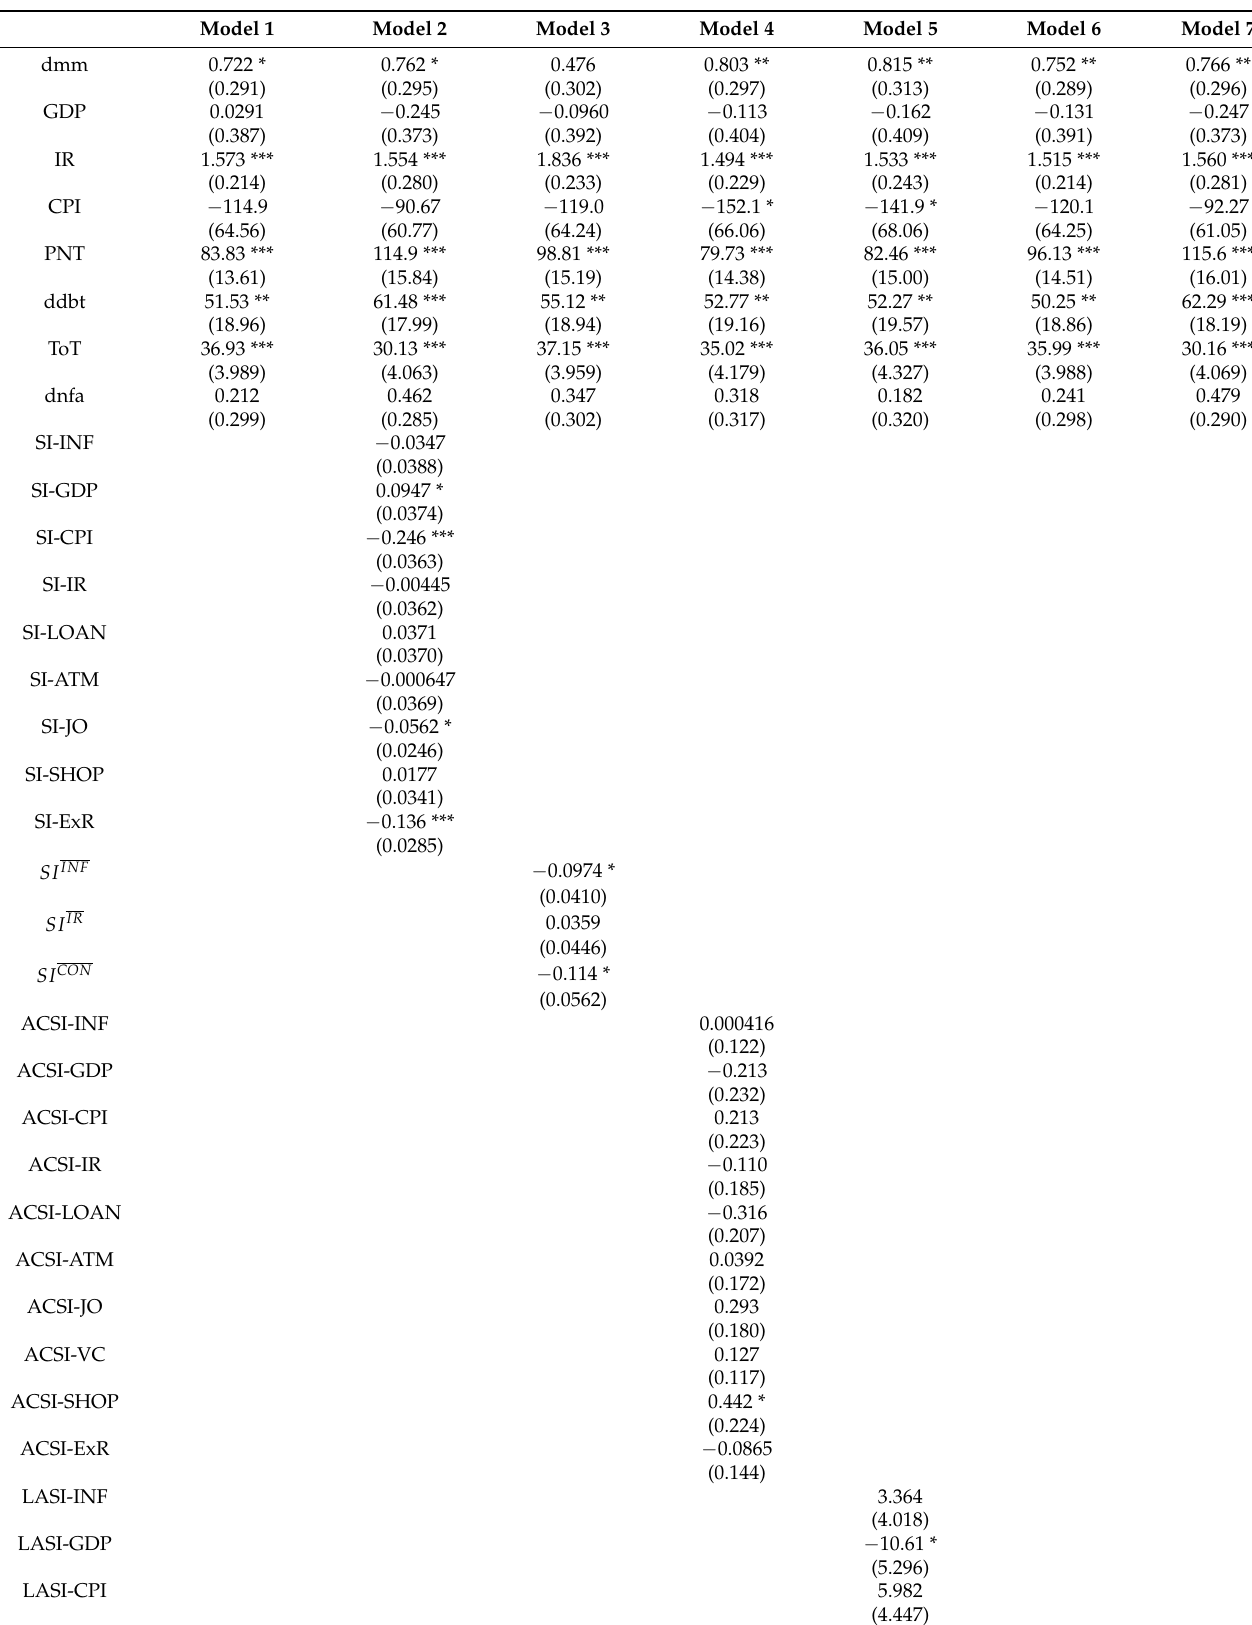
Table A14. Panel Regression Table Fixed-Effects AM Models